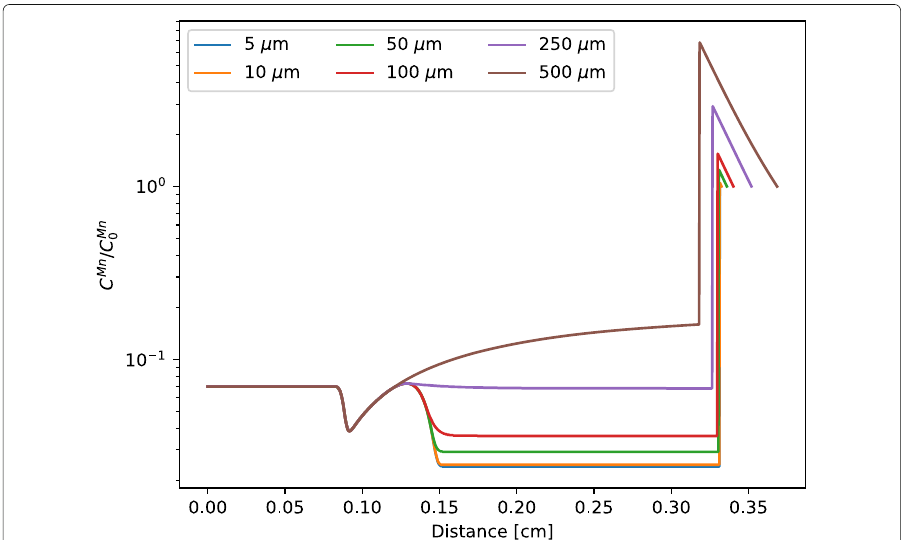
Fig. 11 Mn-concentration profiles for different moving frame distances. Simulations with G = 10 Kcm − 1 and V pull = 6 μ ms −